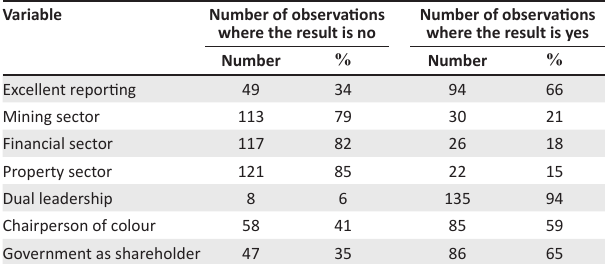
TABLE 1: Description of independent variables. TABLE 2: Classification of the